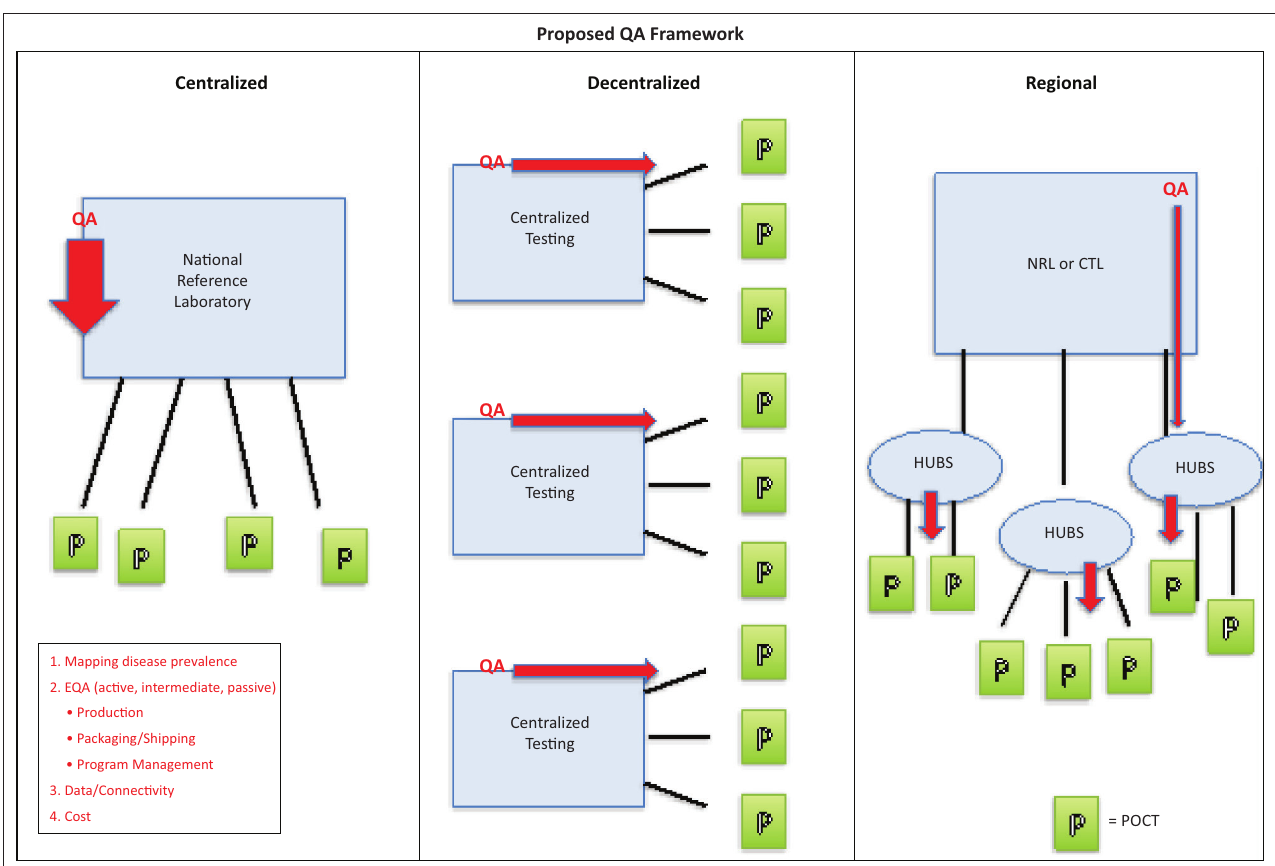
FIGURE 2: Quality assurance models for point-of-care testing integrated within existing laboratory